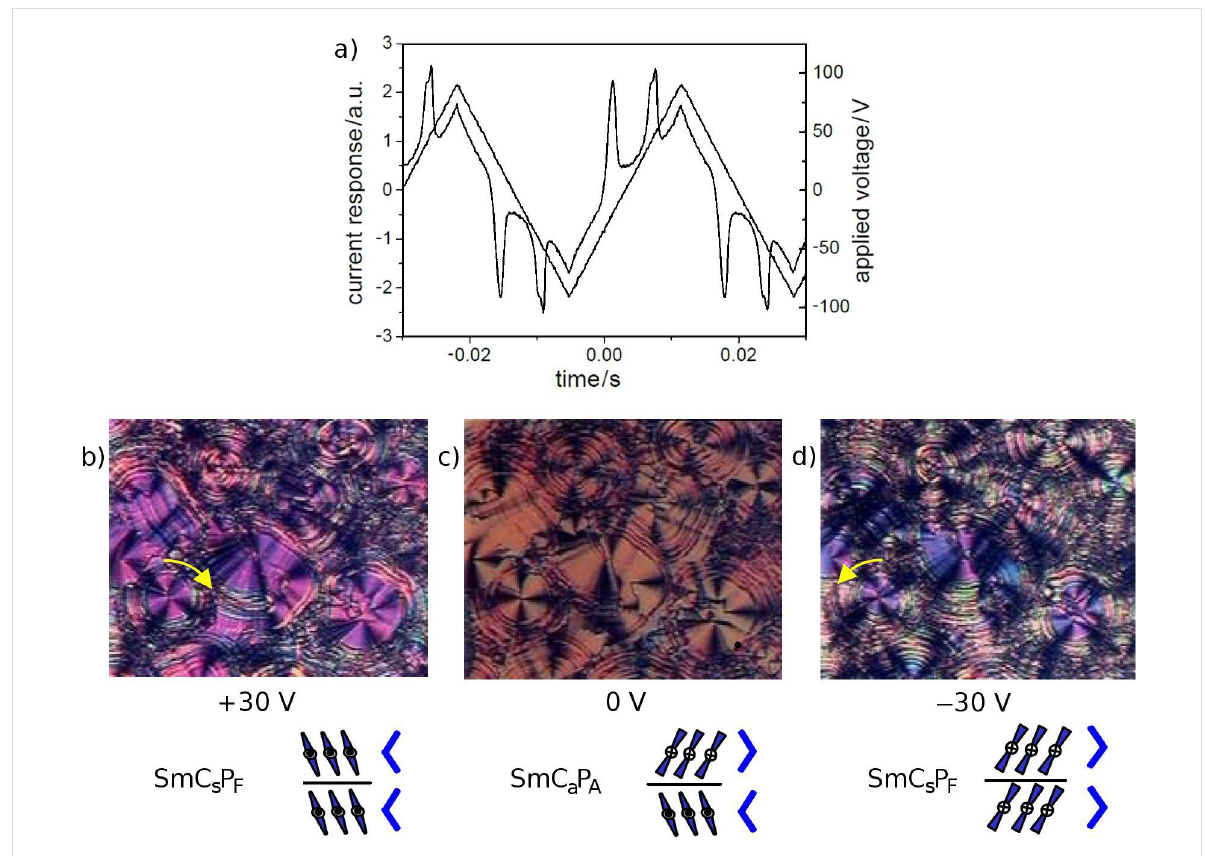
Figure 3: Electro-optical behaviour of compound OH 1a : a) current response curve ( U = 182 V pp , f = 30 Hz, T = 112 °C, d cell = 6 μ m, P S = 900 nC/ cm 2 ); b–d) tristable switching of circular domains by a D.C. voltage. T = 112 °C, d cell = 6 μ m; c) 0 V, extinction crosses parallel to the crossed polariser; b) +30 V, clockwise rotation of the extinction crosses (see yellow arrow); d) − 30 V, anticlockwise rotation of extinction crosses (see yellow arrow).